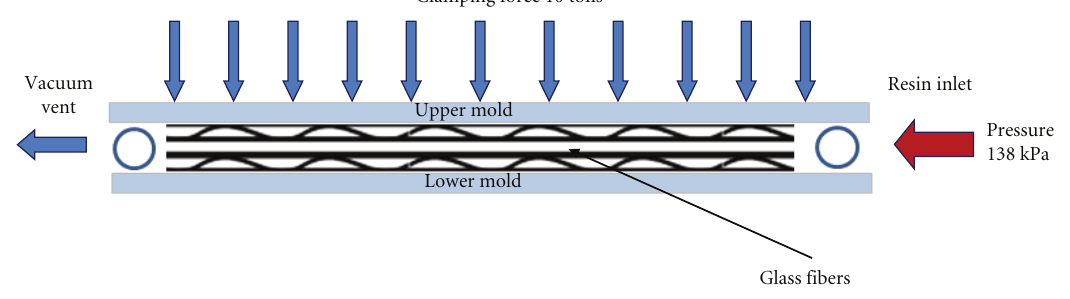
Figure 4: RTM composite manufacturing